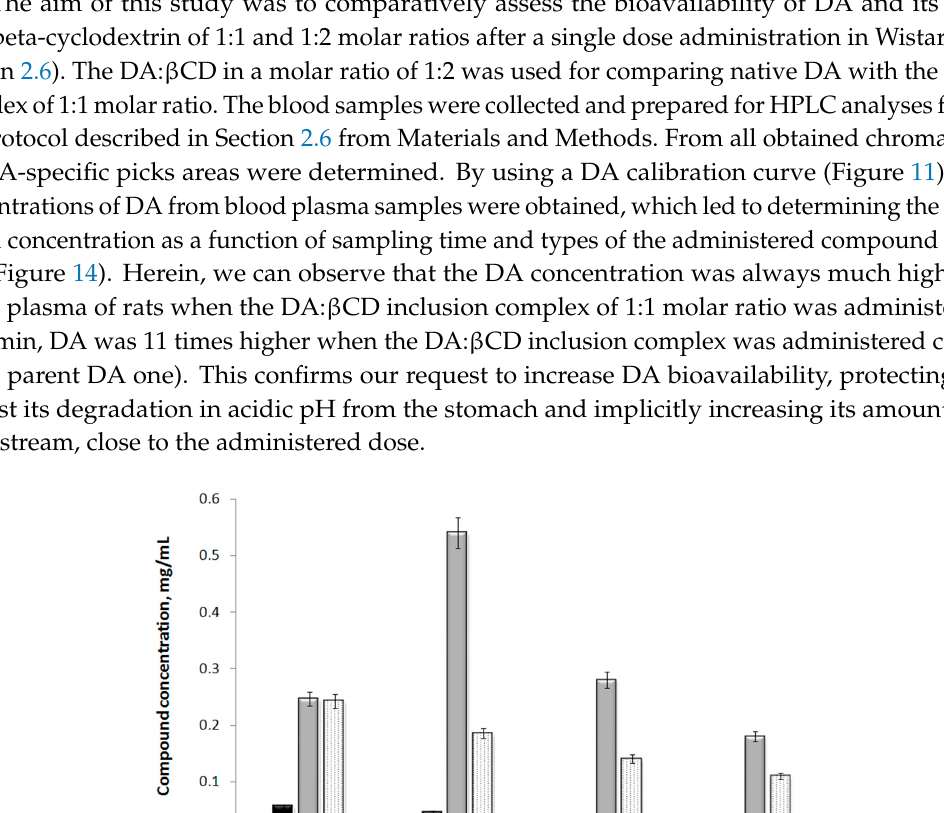
Figure 13. The inhibitory capacity of DA, β CD, and the DA: β CD (1:1 molar ratio) inclusion complex on lipoxygenase activity as a function of DA concentration in the final solution.